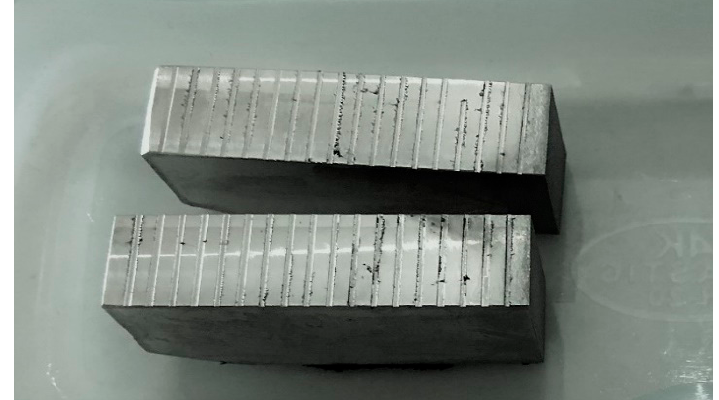
Figure 1. Sample of the machined workpiece. Four factors were investigated to find their effects on burr formation and surface roughness. These factors are (a) three different tool coatings, (b) three levels of feed rate ( µ m/tooth) below the cutting-edge radius, (c) three levels of cutting speed in conventional cutting speed range and (d) three levels of depth of cut. Details of these parameters and their levels are given in Table 3. In this research, Analysis of Variance (ANOVA) was used to find the influence of each parameter on burr formation and surface analysis, and the Taguchi method was used to find the best parameters for minimum burr formation and surface roughness. It uses a special method to study the entire range of parameters with a limited number of experiments using orthogonal arrays. These 9 trials were performed twice to check the repeatability of the experiments. Table 3. Details of machining parameters.